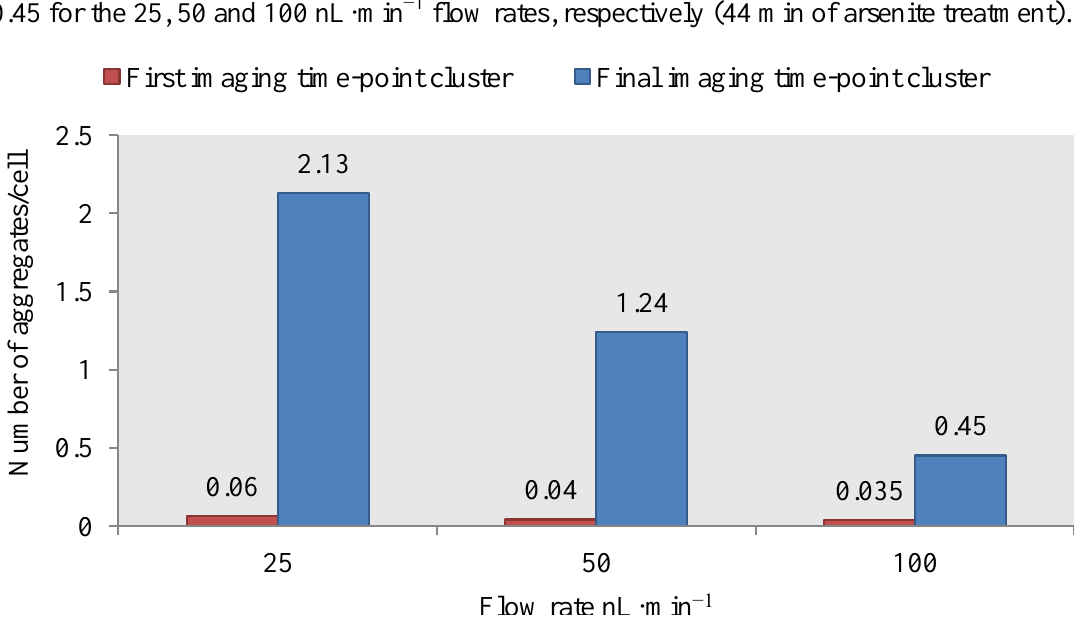
Figure 4. Effect of the flow rate modulation on arsenite uptake by yeast cells in the microfluidic system. Three different flow rates of 25, 50 and 100 nL min −1 were investigated. To determine the arsenite exposure effect on relocalization of the Hsp 104-GFP protein and for the sake of comparison “number of aggregates per cell” measure was calculated in the three different cases. The number of aggregates/cell values in the first imaging time-point cluster (when the arsenite treatment is initiated) are 0.06, 0.04 and 0.035 while these values in the last imaging time-point cluster increase to 2.13, 1.24